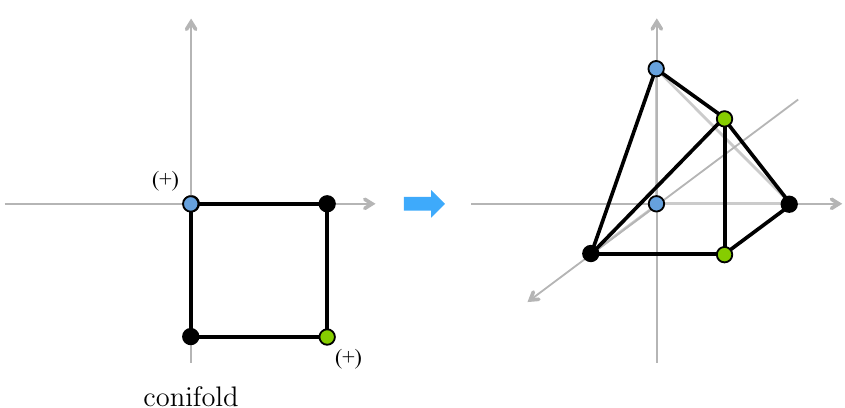
Figure 12. The toric diagram of H 4 , obtained by lifting two perfect matchings of the conifold.